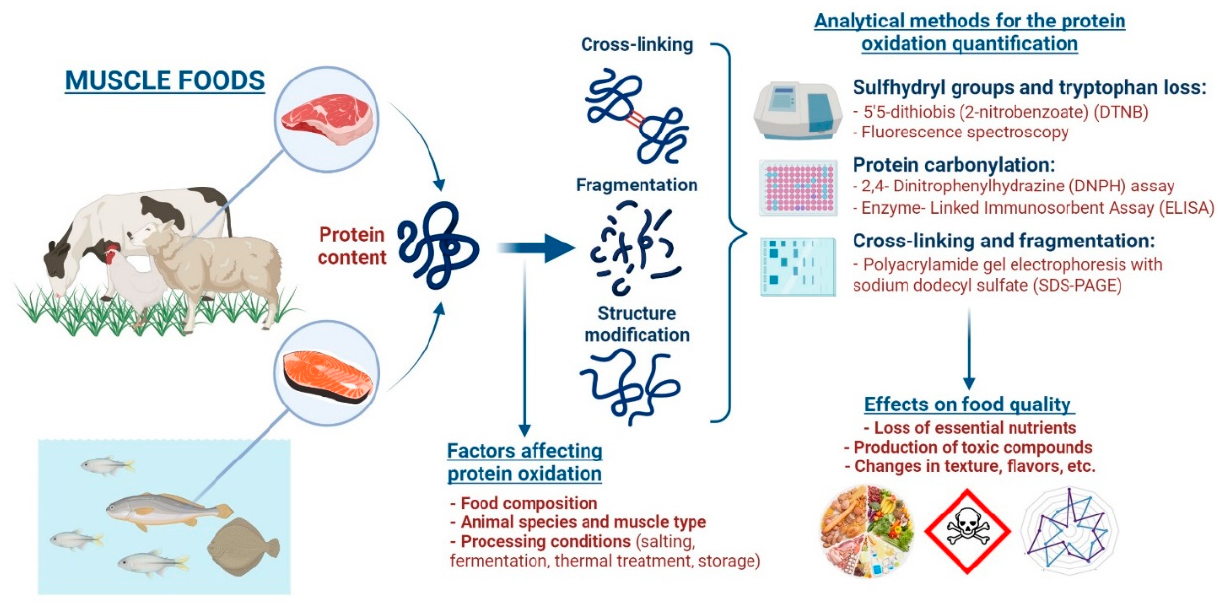
Figure 1. Schematic representation of the main mechanisms and factors that affect protein oxidation, different analytical methods for quantifying protein oxidation, and the detrimental effects of protein oxidation on muscle food quality.